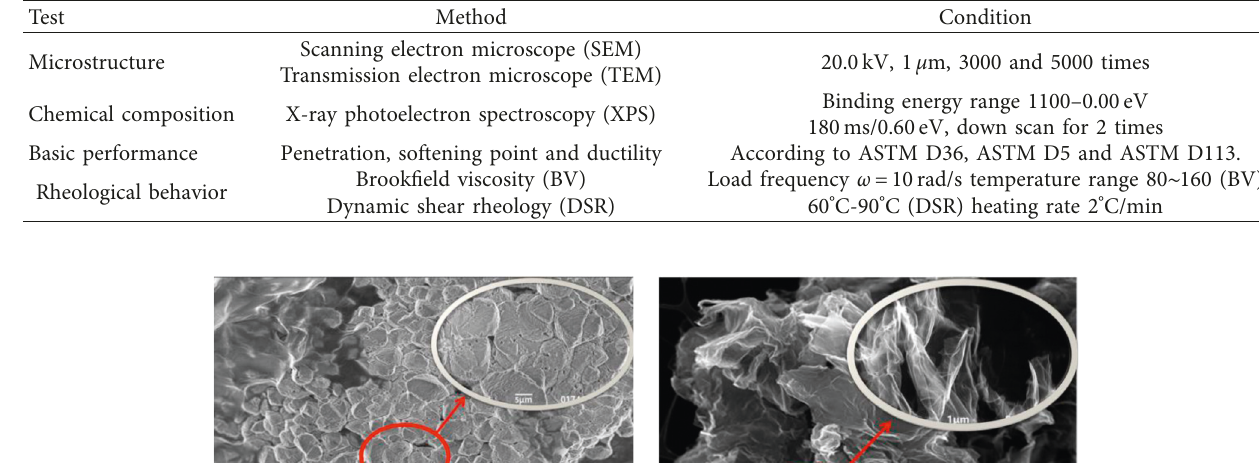
Figure 2: Main test instruments for this work. (a) SEM, (b) TEM, (c) DSR, and (d) XPS. Table 5: Detail information of